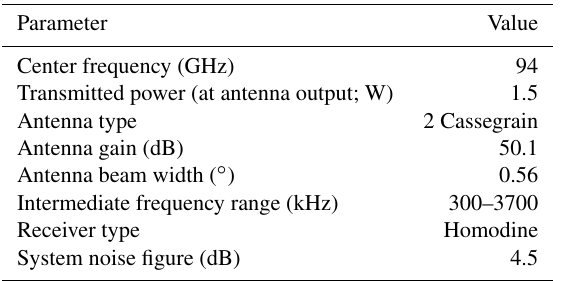
Table 1. Some key technical specifications of the analyzed W-band radars.